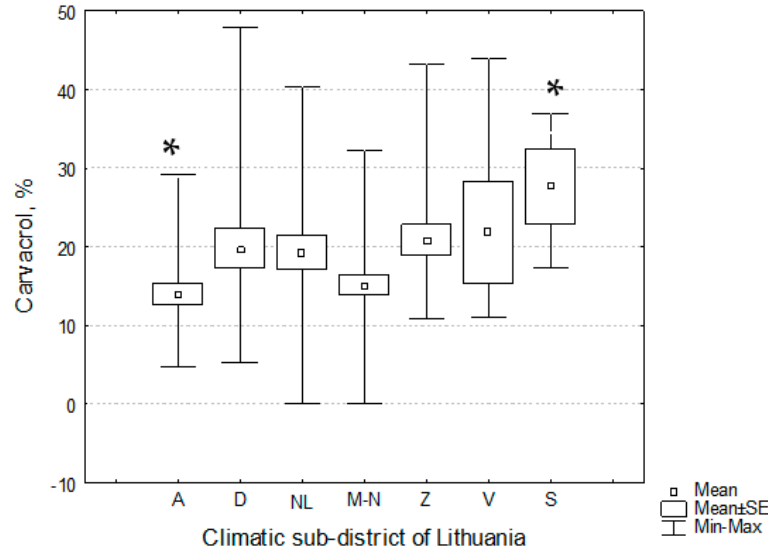
Figure 4. Distribution of the amount of carvacrol in the essential oils of Thymus pulegioides habitats in different climatic sub-districts of Lithuania. Explication: A—Aukštaitija climatic sub-district, D—Dz ū kija, M-N—M ū ša Nev ė žis, NL—the Nemunas Lowland, S—S ū duva, V—Venta, Z—Žemai č iai. * denote statistically significant ( p < 0.05) differences.